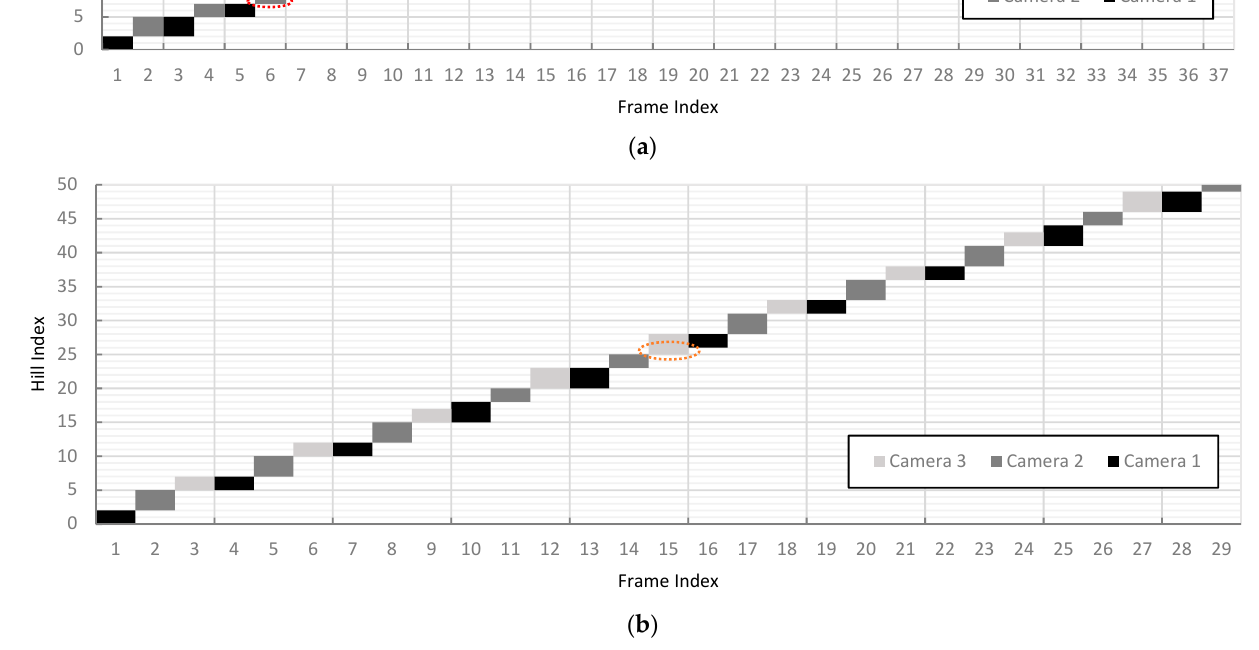
Figure 12. The range of plant hill indices detected per frame along the first 10 m of the simulated field at f ps = 2.4, S = 0.5 m, and d h = 0.2 m: ( a ) detections at 1.3 m/s using two cameras where broken red lines represent plant hills undetected by the first camera but detected by the second camera; and ( b ) detections at 2.5 m/s and three cameras where broken orange lines represent plant hills undetected by the first and second cameras but detected by the third camera.